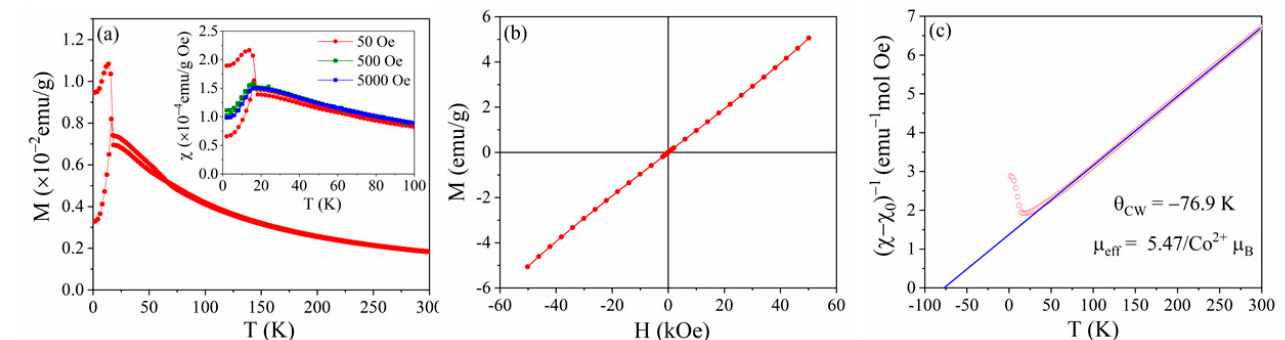
Figure 6. ( a ) M versus T of Co 15 (TeO 3 ) 14 (OH) 2 at 50 Oe. Inset shows magnetic susceptibility χ = M/H vs. T recorded for different magnetic fields. ( b ) M versus H at 2 K. ( c ) ( χ − χ 0 ) − 1 vs. T after correcting for a background contribution χ 0 ( − 0.0168 emu/mol · Oe).